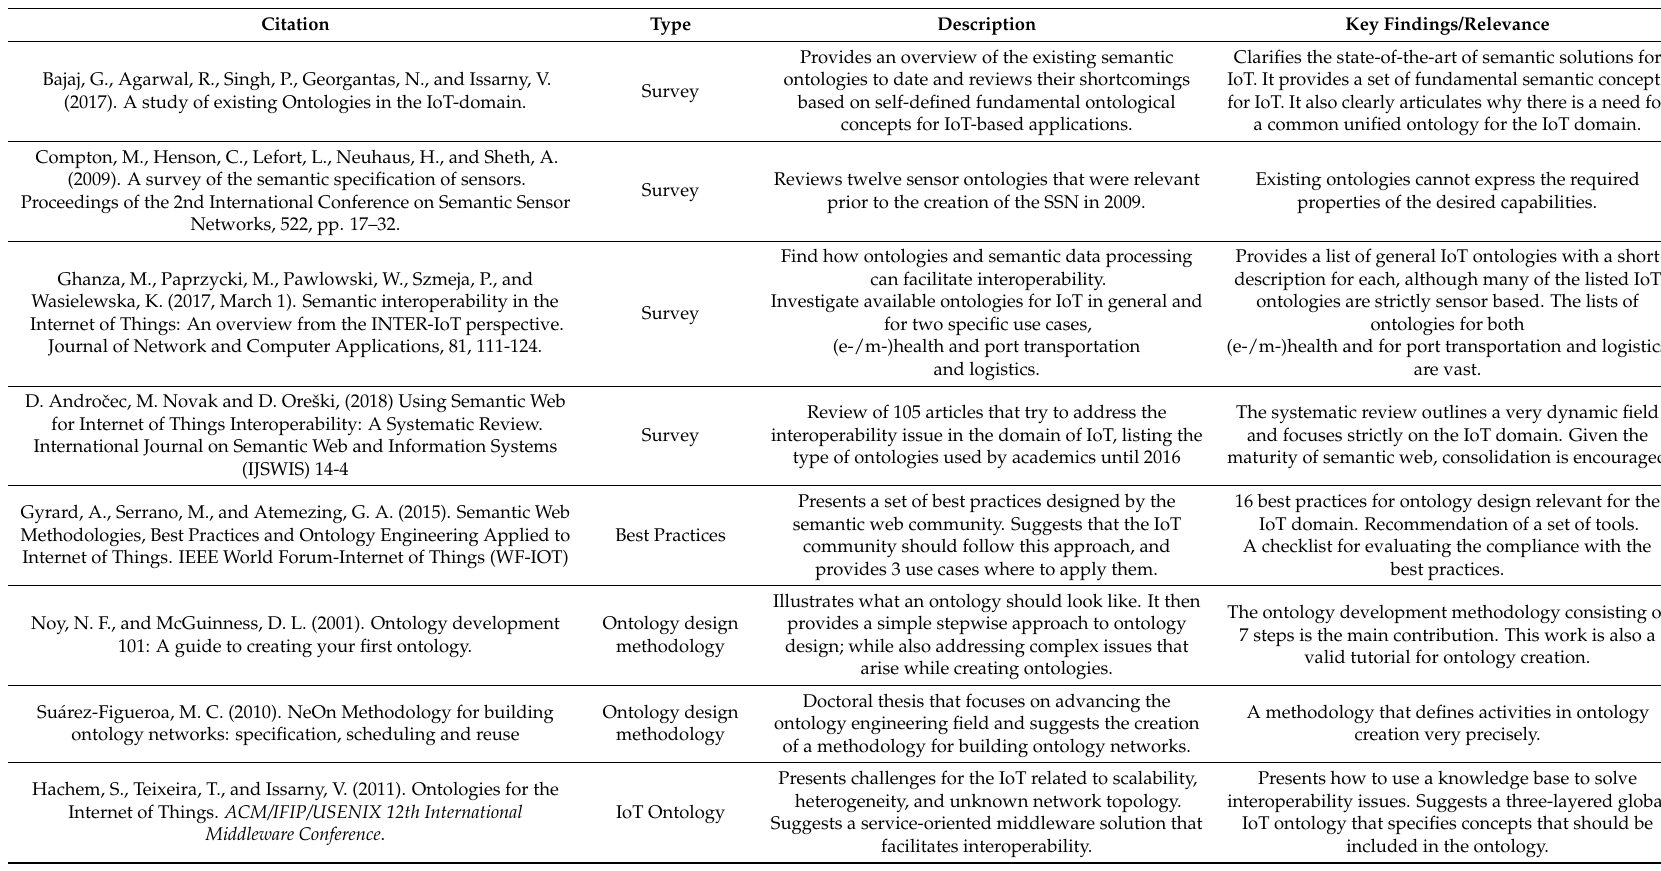
Table 1. Works in semantic IoT that are relevant for achieving an “intelligent interoperability” in Industry 4.0. SSN, Semantic Sensor